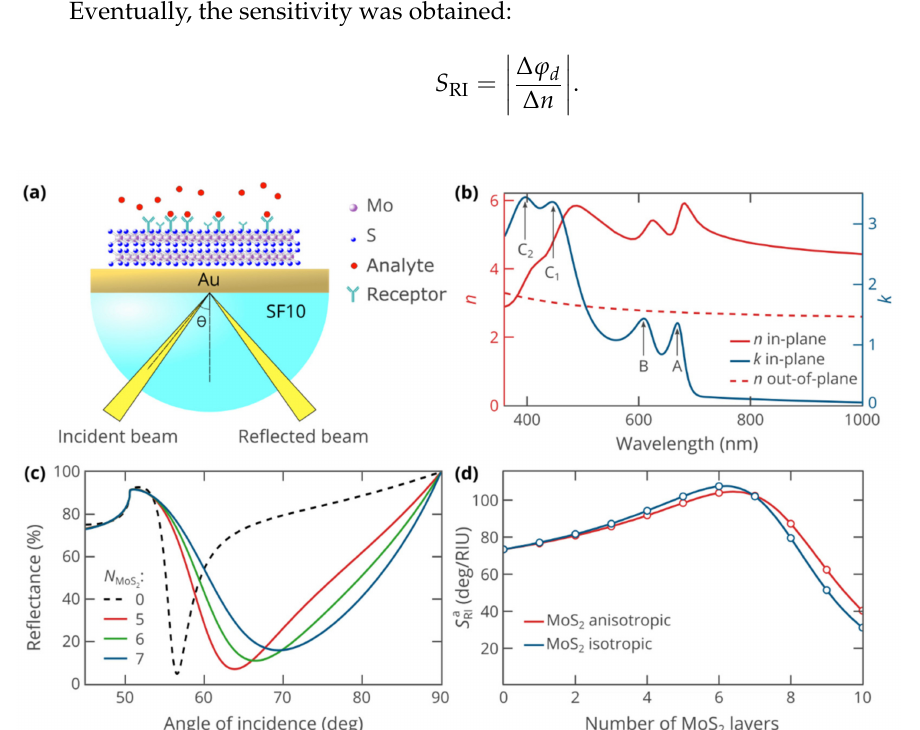
Figure 1. ( a ) Schematic view of the studied SPR biosensor operation; ( b ) Anisotropic optical properties of MoS 2 nanosheets [32,36]. “A, B, C 1 , C 2 ” label the excitonic absorption peaks; ( c ) Reflectance as a function of the angle of incidence at a wavelength of 633 nm and varying number N MoS layers. Black dashed curve represents the reference biosensor without the MoS 2 cover ( N MoS SPR curves are plotted assuming that the analyte layer is pure water; ( d ) The sensitivity of SPR biosensor as a function of the thickness of the MoS 2 layer. In calculations using isotropic optical properties of MoS 2 , we set ε = ε (cid:107)